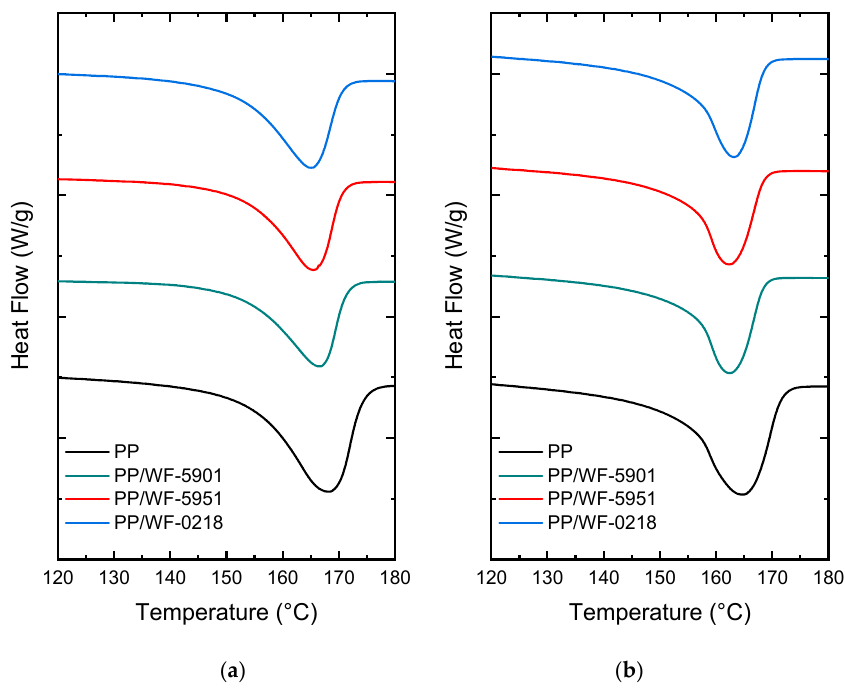
Figure 5. DSC heating scan for ( a ) the first heating and ( b ) the second heating scans from the gauge length of the injected tensile specimens. Table 3. Thermal parameters of PP and PP/WF composites from the gauge length of tensile specimens.